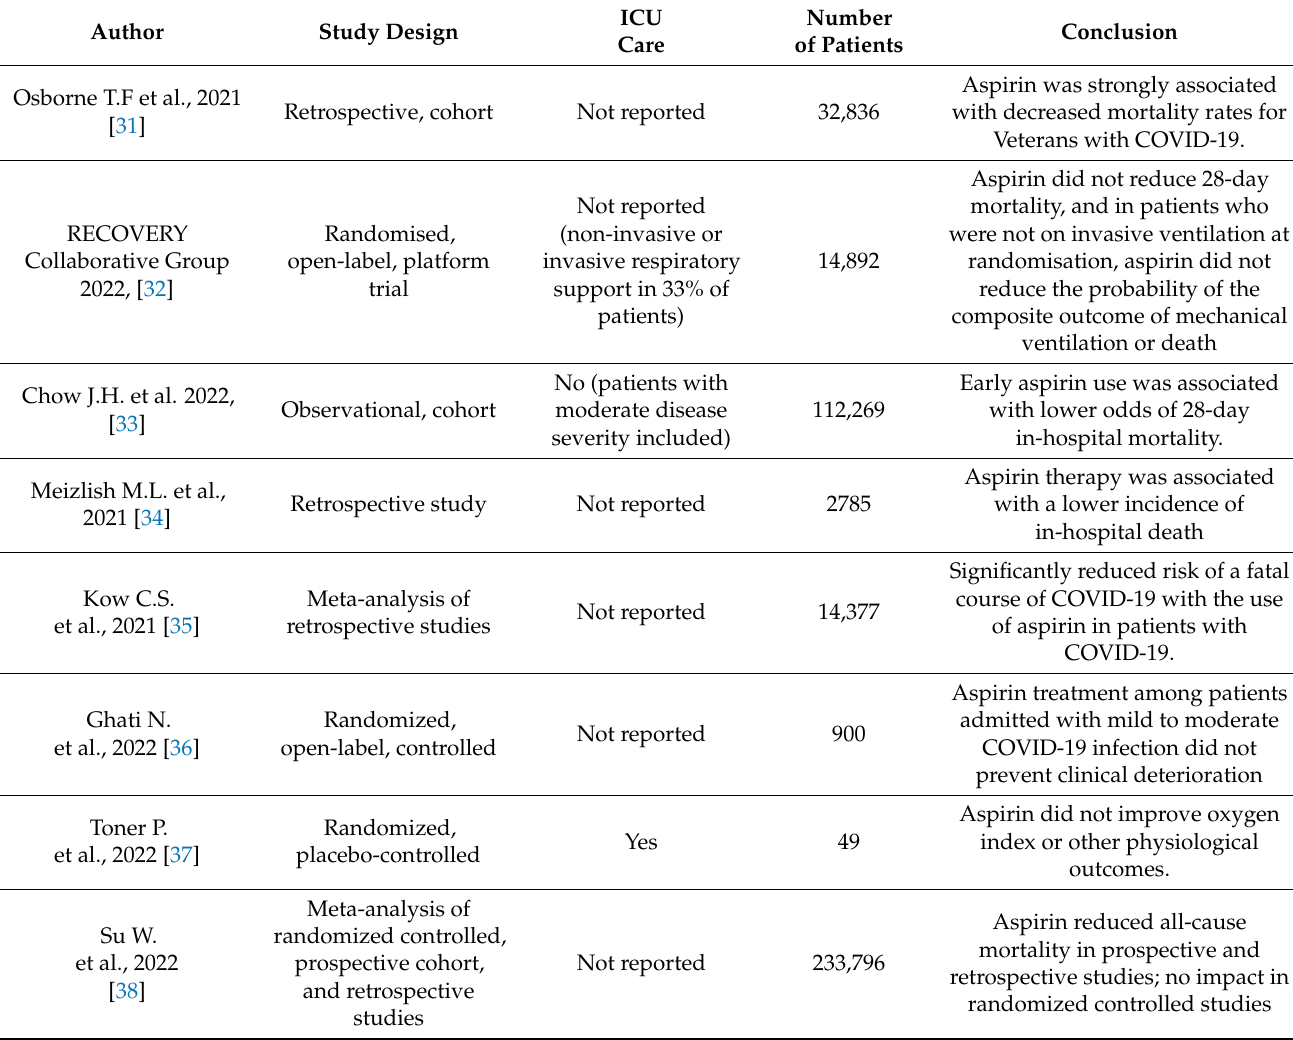
Table 1. Aspirin therapy in patients with COVID-19